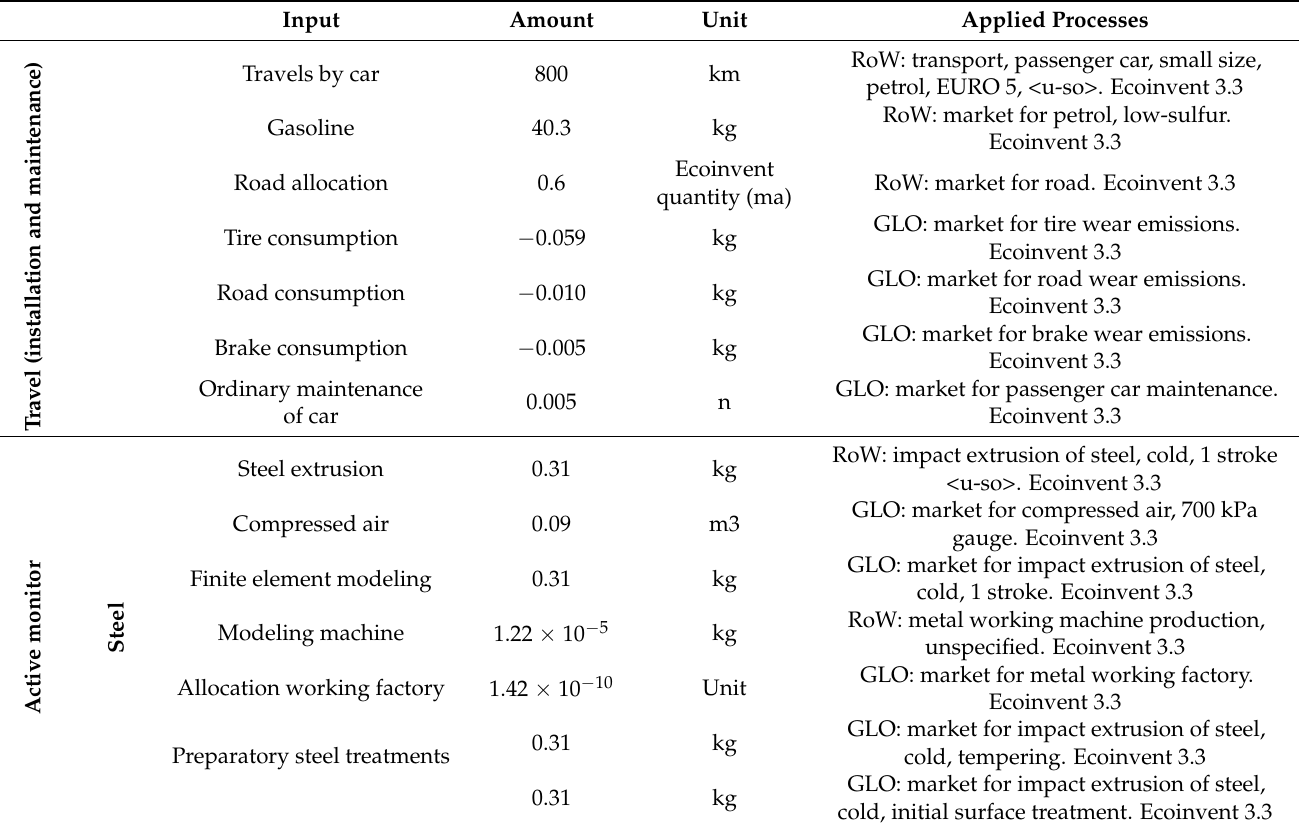
Table 3. Summarized inventory of inputs and outputs referred to the case study of ozone monitoring with active sensors. The initial acronyms in “applied processes” refer to geographic location: “RER” = Europe; “GLO” = global; “Row” = rest of the world.